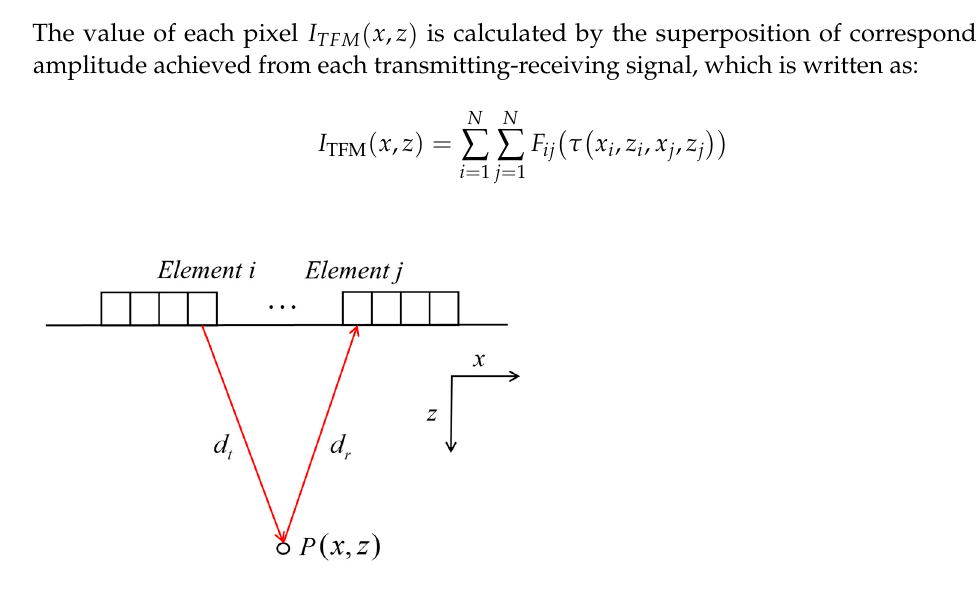
Figure 3. Reception at array element i while element j emitting.